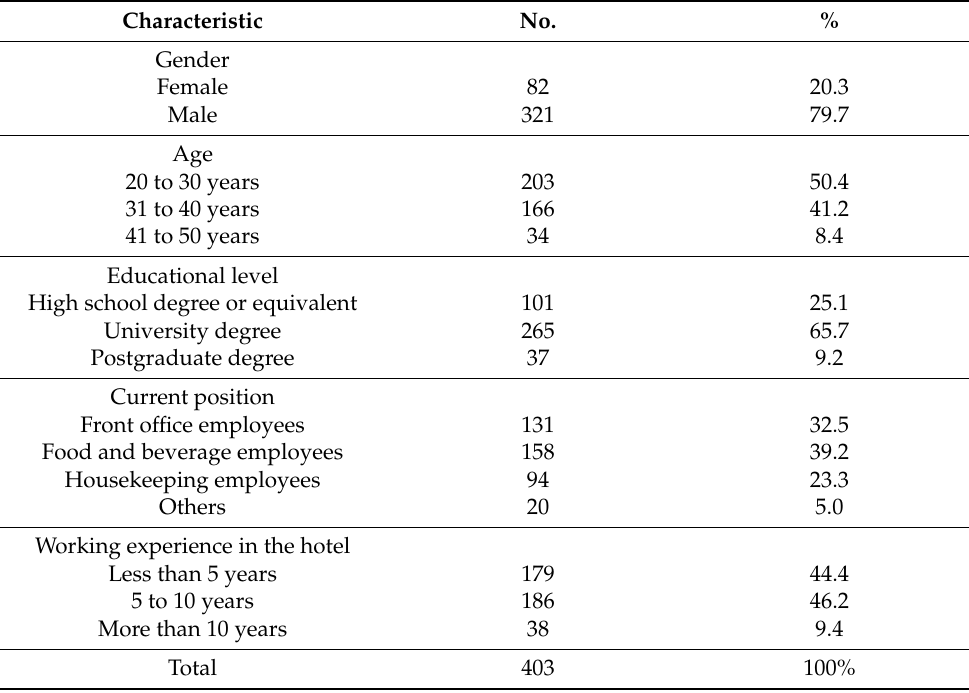
Table 1. The respondents’ demographic